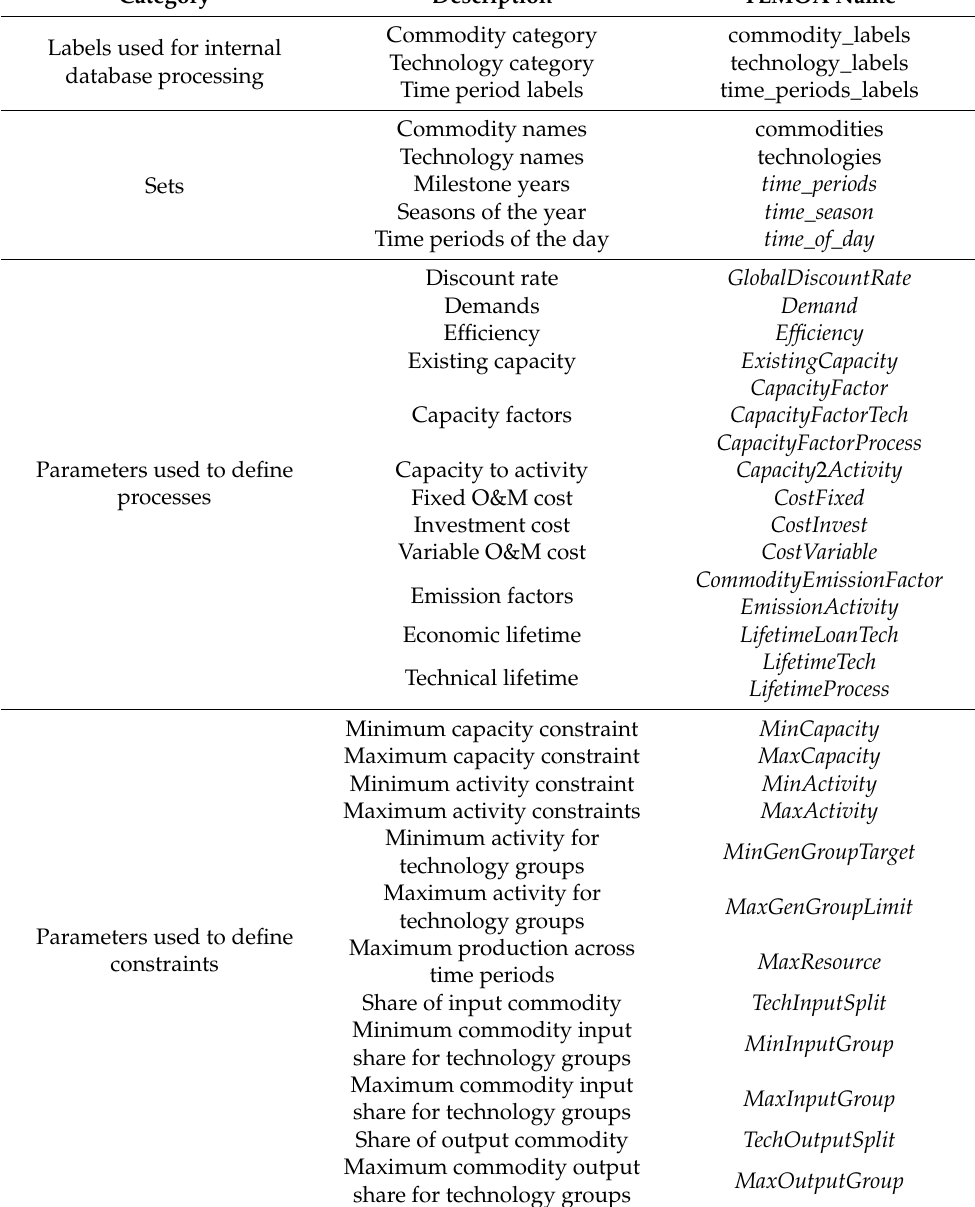
Table 2. Main items included in the TEMOA database. New parameters introduced within this study and parameters whose formulation has been modified with respect to the original TEMOA version are highlighted in